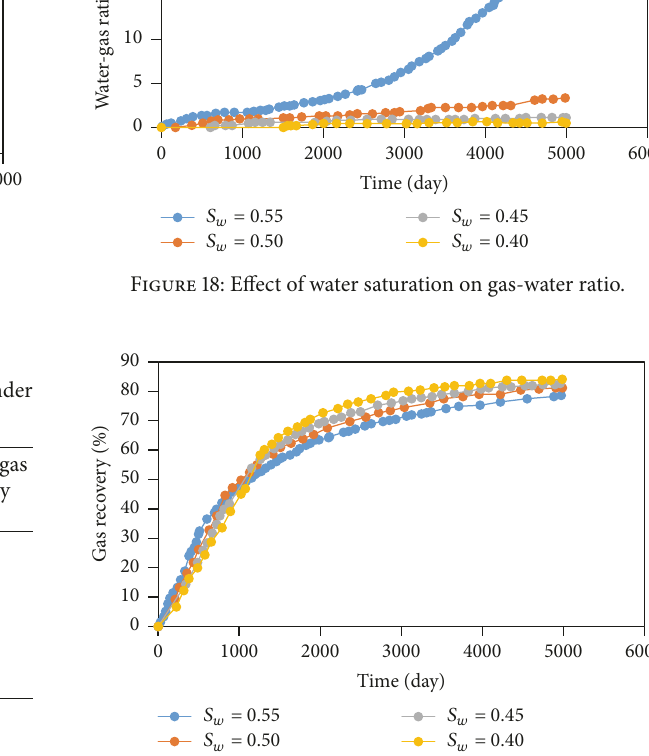
Figure 19: Effect of water saturation on gas